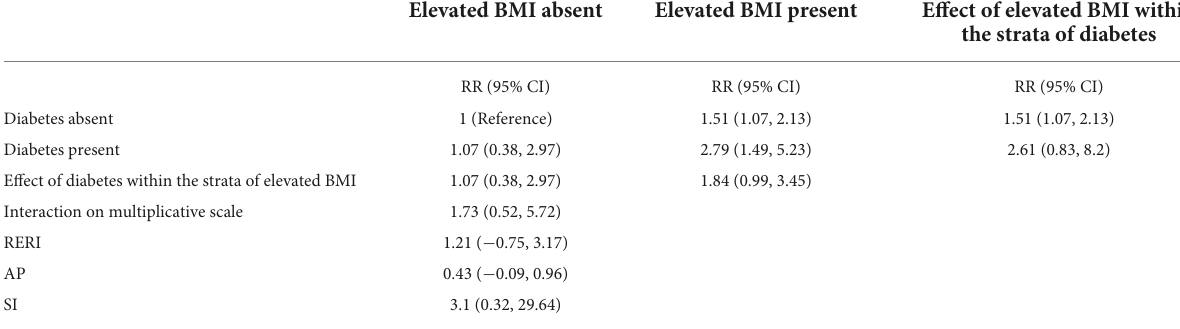
TABLE 4 Assessment of interaction between elevated maternal pre-pregnancy BMI ( ≥ 25) and maternal diabetes. Elevated BMI absent